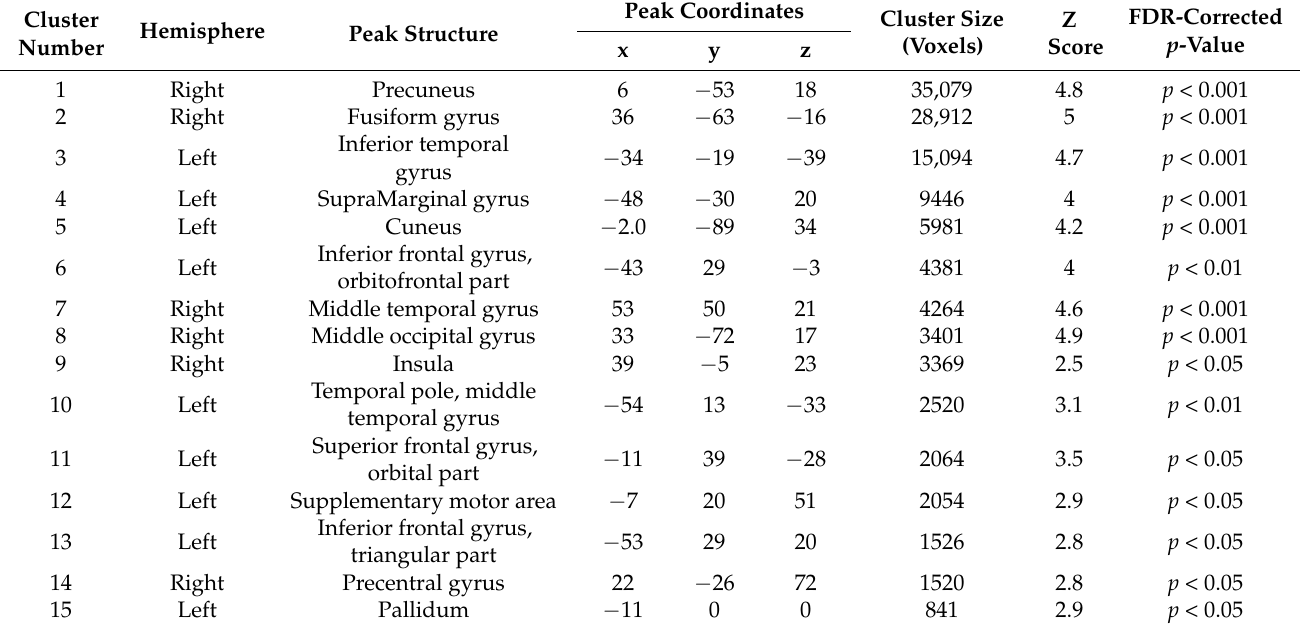
Table 2. Top 15 VBM clusters in which gray matter volume was significantly reduced in BINT participants compared to occupational stress control participants.